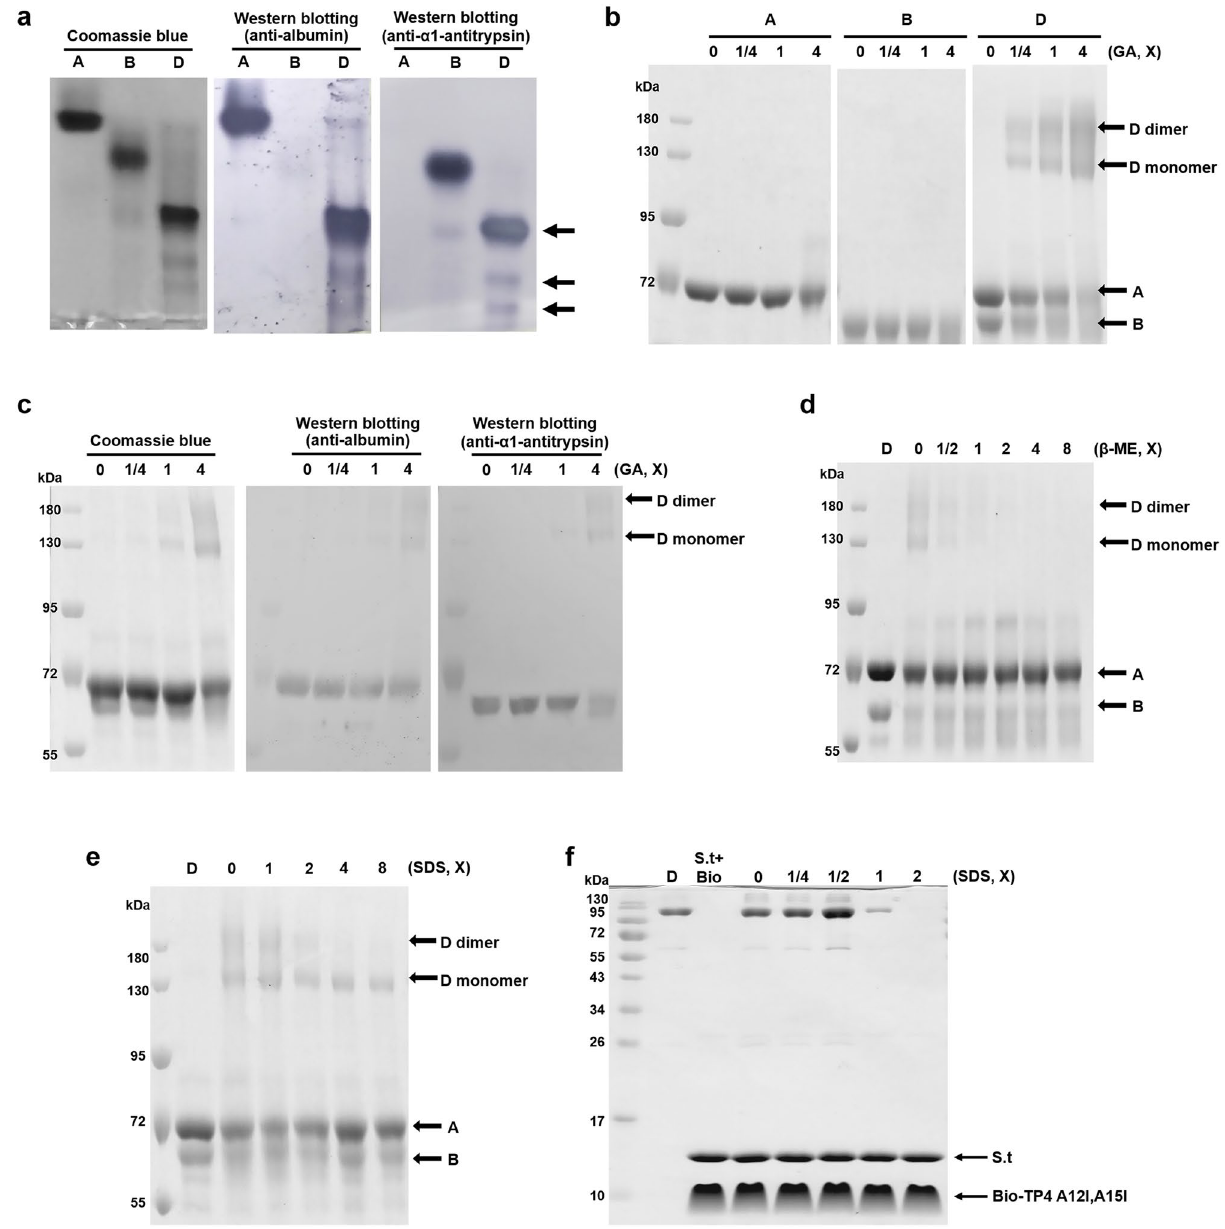
Figure 5. Dimerization of protein D is essential for AMP binding. ( a ) Protein D is composed of protein A and B detected by non-reducing SDS-PAGE followed by Western blotting using antibodies raised against protein A (albumin, middle) and protein B (α1-antitrypsin, right). ( b , c ) Dimerization of protein D. The proteins A, B and D were cross-linked with glutaraldehyde (GA) and separated by 8% reduced SDS-PAGE ( b ). The cross-linked protein D was further analyzed by Western blotting using antibodies raised against protein A (albumin, middle) and protein B (α1-antitrypsin, right) ( c ). 1X GA represents 0.00625% glutaraldehyde. ( d , e ) Inhibition of dimerization of protein D by β-mercaptoethanol (β-ME) and SDS. The protein D was cross-linked with 0.025% glutaraldehyde in the presence of β-ME ( d ) or SDS ( e ). 1X represents 0.05% β-ME ( d ) and 0.0625% SDS ( e ), respectively. ( f ) SDS inhibit the pulled-down of protein D to immobilized TP4-A12I,A15I which analyzed by 15% non-reducing SDS-PAGE. 1X represents 0.0625%